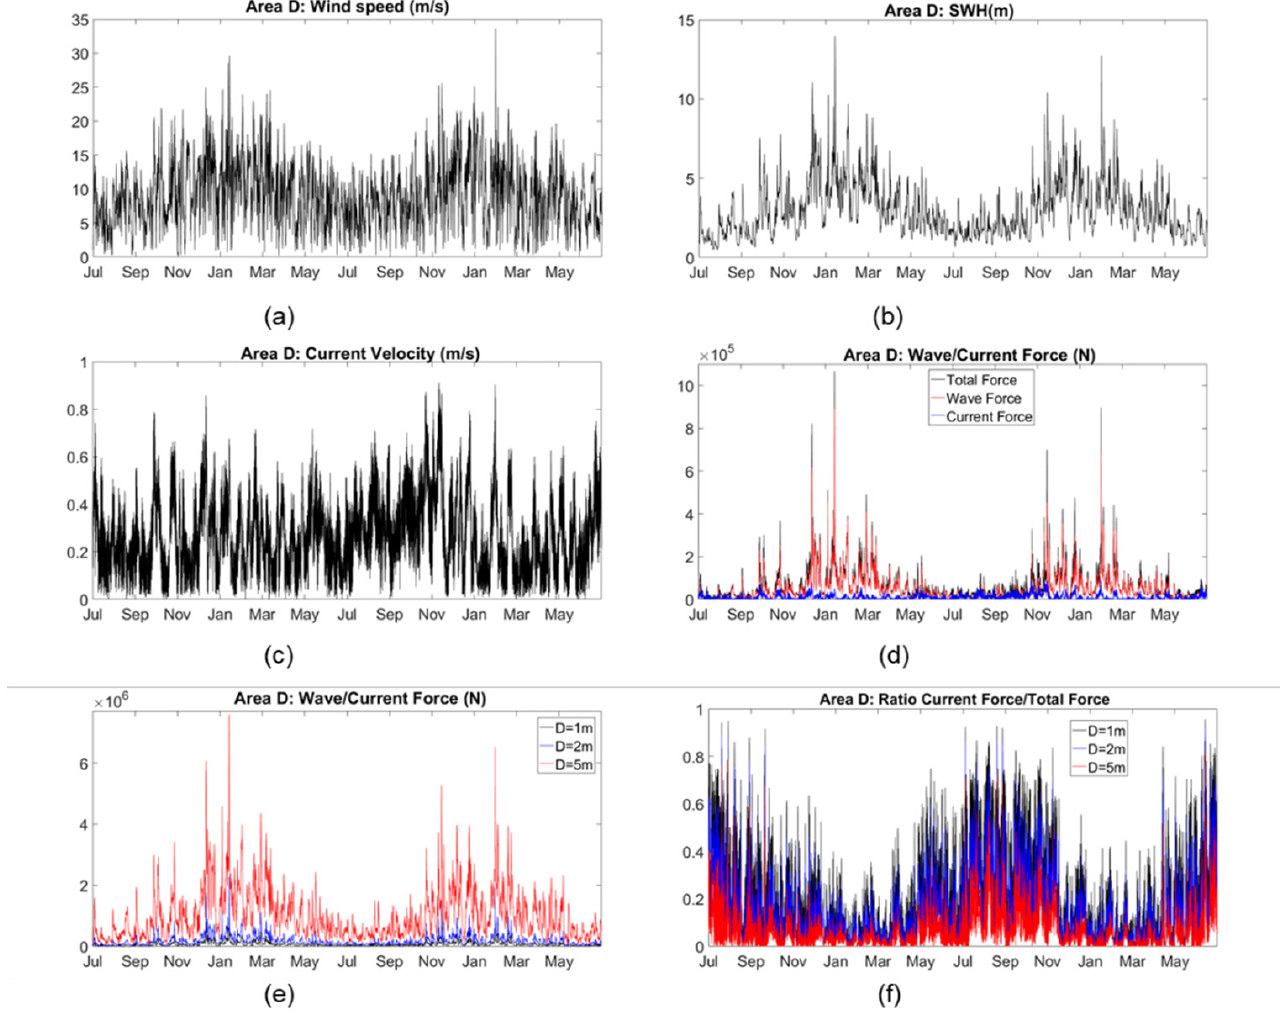
Figure 11. Area D hourly time series (7/2014–6/2016) of area-averaged wind speed (m/s) ( a ) Significant Wave Height (m) ( b ), Current velocity (m/s) ( c ), total wave/current force (N) (black), wave force (N) (red) and current force (N) (blue) ( d ) on a pile of diameter D = 1 m. Timeseries of total force ( e ) and ratio of current to total Force ( f ) for D =1 m, D =2 m, and D =5 m. Mean total wave/current force over the 2-year period strongly increases with pile diameter (Figure 11), from ~6.6 × 10 4 N ( D = 1 m) to 1.9 × 10 5 N for D = 2 m and to 1 × 10 6 N for D = 5 m. On average, current contribution to total hydrodynamic force decreases from 22% for a diameter of D = 1 m to 14% for D = 2 m, and to 7% for D = 5 m. For the case of floating structures with a typical diameter of the submerged pile of 10 m, the hydrodynamic force mean value is 3 × 10 6 N, whilst total hydrodynamic force can reach extreme values of 2–2.5 × 10 7 N during severe storms (Figure 12). Maximum hydrodynamic force is about five times larger, as compared with a floating pile of a diameter of 5 m. On average, current contribution to total hydrodynamic force is much lower,